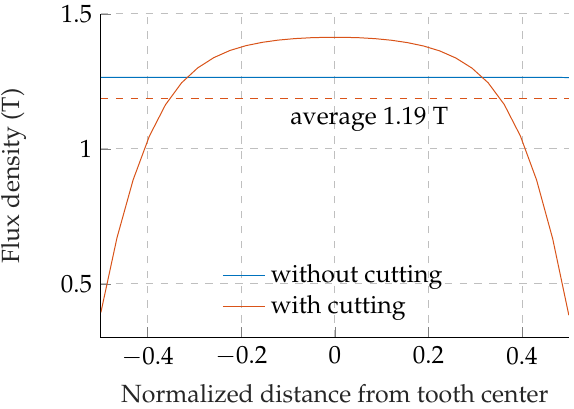
Figure 9. Comparison of flux density distribution in stator tooth.